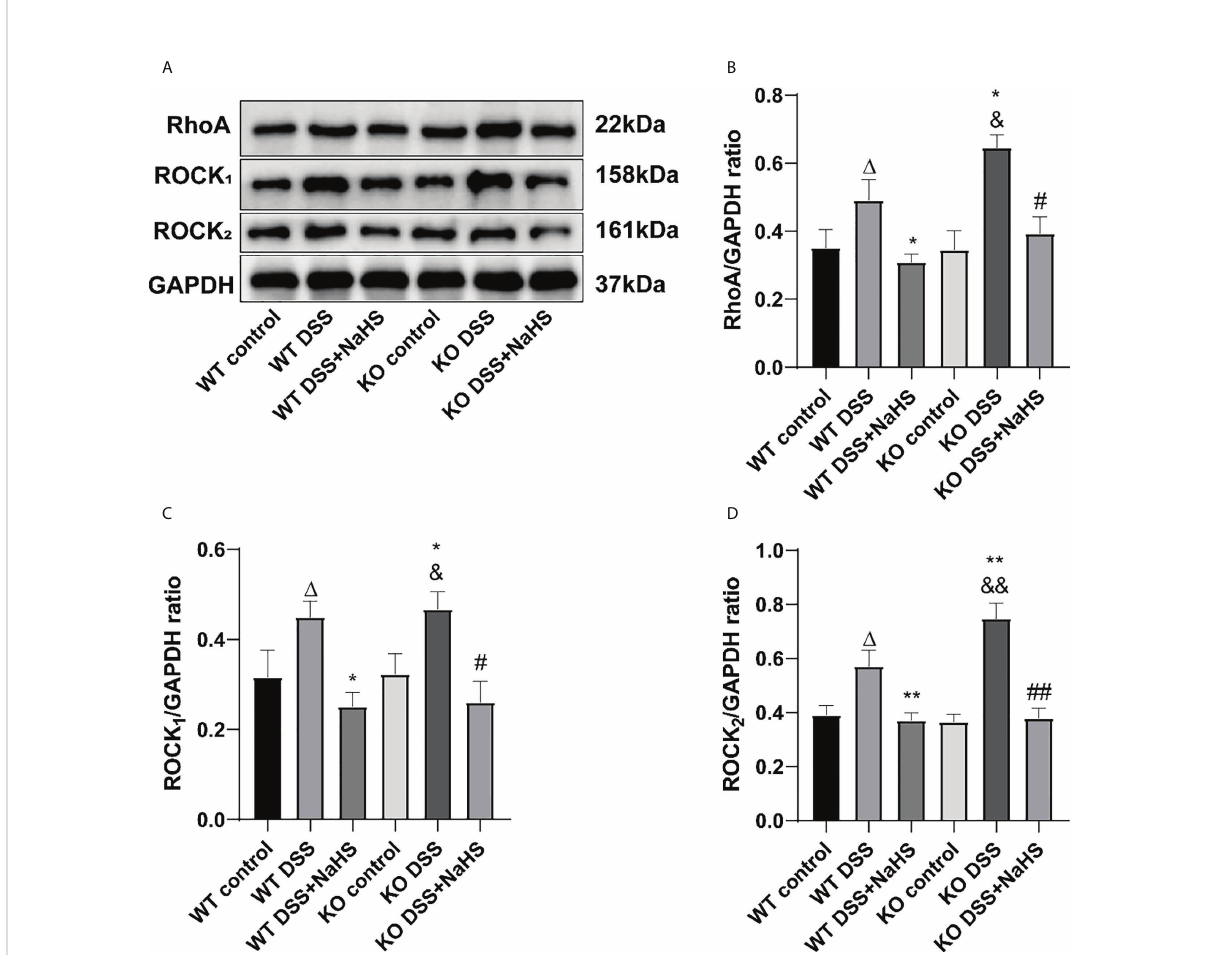
FIGURE 7 Effects of cystathionine- g -lyase (CSE)-derived hydrogen sul fi de (H 2 S) on the expression of RhoA, Rho kinase 1 (ROCK 1 ), and Rho kinase 2 (ROCK 2 ) proteins in colon. Data are expressed as the mean±SEM, N=3. (A) The bands of RhoA, ROCK 1 , and ROCK 2 . (B) The relative expression of RhoA in colon. (C) The relative expression of ROCK 1 in colon. (D) The relative expression of ROCK 2 in colon. D P<0.05 vs